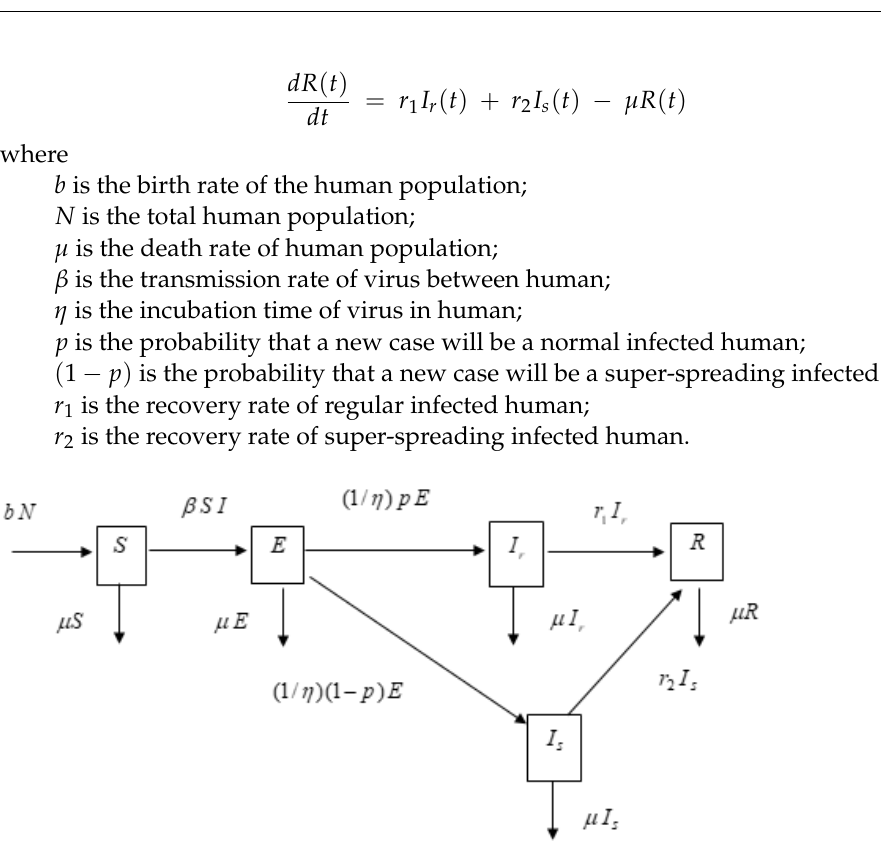
Figure 1. Diagram for the dynamical transmission of respiratory disease. In the above flow chart, the variables are: S is the number of susceptible human population; E is the number of exposed human population; I r is the number of normal infected human; I s is the number of super-spreading infected human; I is the total infected human population, I = I r + I s ; R is the number of recovered human population.